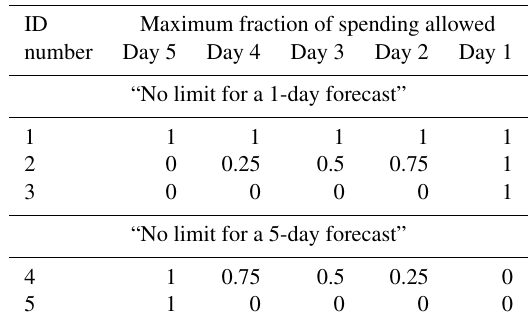
Table 2. Maximum fraction of total spending s allowed, depending on the forecasting horizon. Each spending vector is identified by an identification number (ID) for further